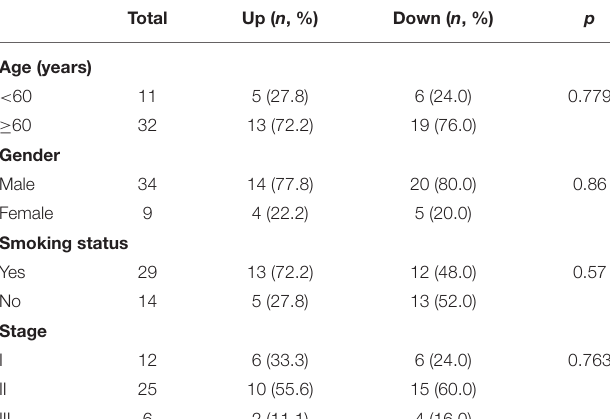
TABLE 3 | The characteristics of 43 patients for clinical validation.